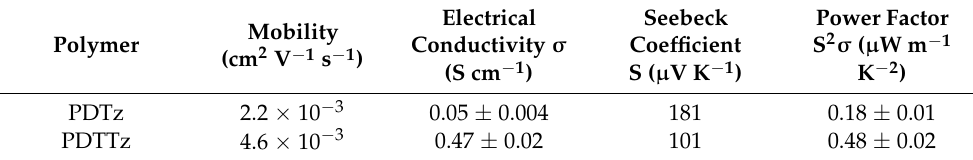
Figure 3. OTFT characteristics. Transfer curve of ( a ) PDTz and ( b ) PDTTz displaying the saturation regime for V g = − 80 V, and output curves of ( c ) PDTz and ( d ) PDTTz taken at different gate voltages. Charge carrier mobility of ( e ) PDTz and ( f ) PDTTz at different temperatures. Table 2. Summary of OTFT and OTE